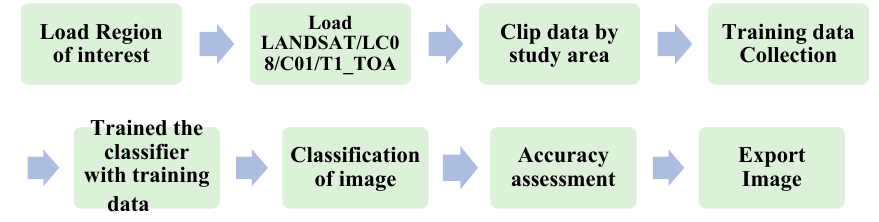
Figure 2. Flow chart for developing Land Use–Land Cover Map.